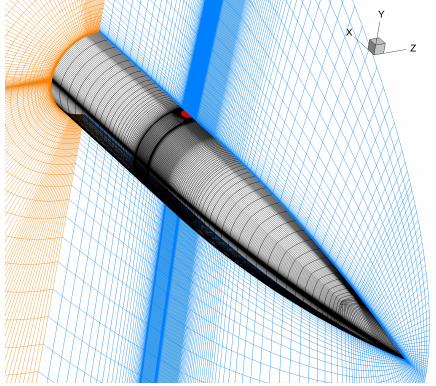
Figure 4. Computational Mesh for Validation